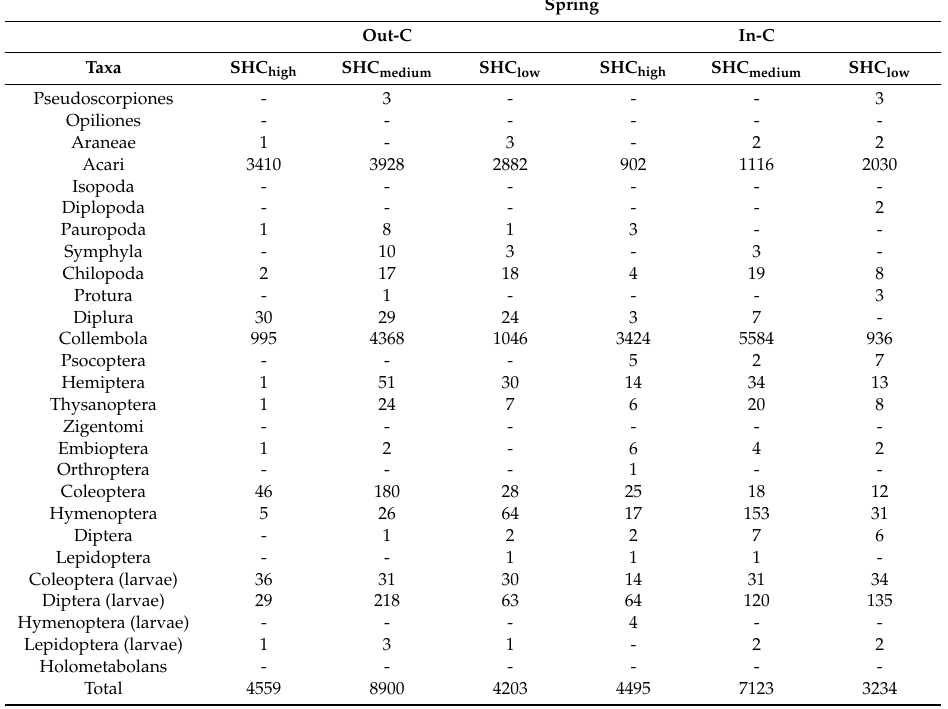
Table A6. Absolute numbers of microarthropod found at each SHC (high, medium and low livestock pressure), in each Location (beneath tree canopy = In-C or outside the canopy = Out-C) during the first sampling campaign.